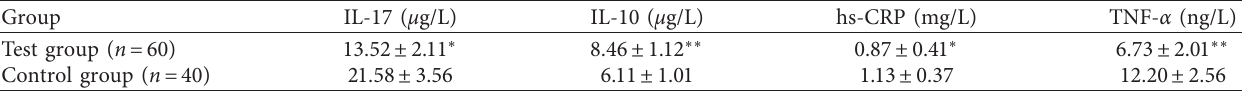
Table 3: The serum levels of IL-17, IL-10, hs-CRP, and TNF- α between the test and control groups. Group